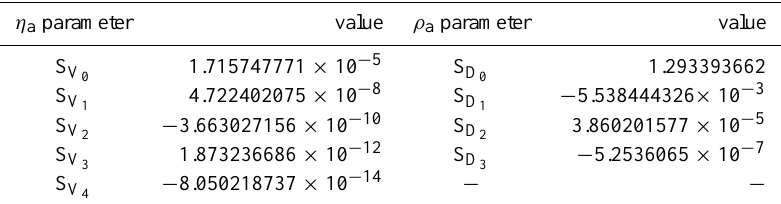
Table A1. Parameters for calculating the dynamic viscosity ( η a ) and density ( ρ a ) according to Tsilingiris (2008). These values are for substitution into Eqs. (24) and (25).